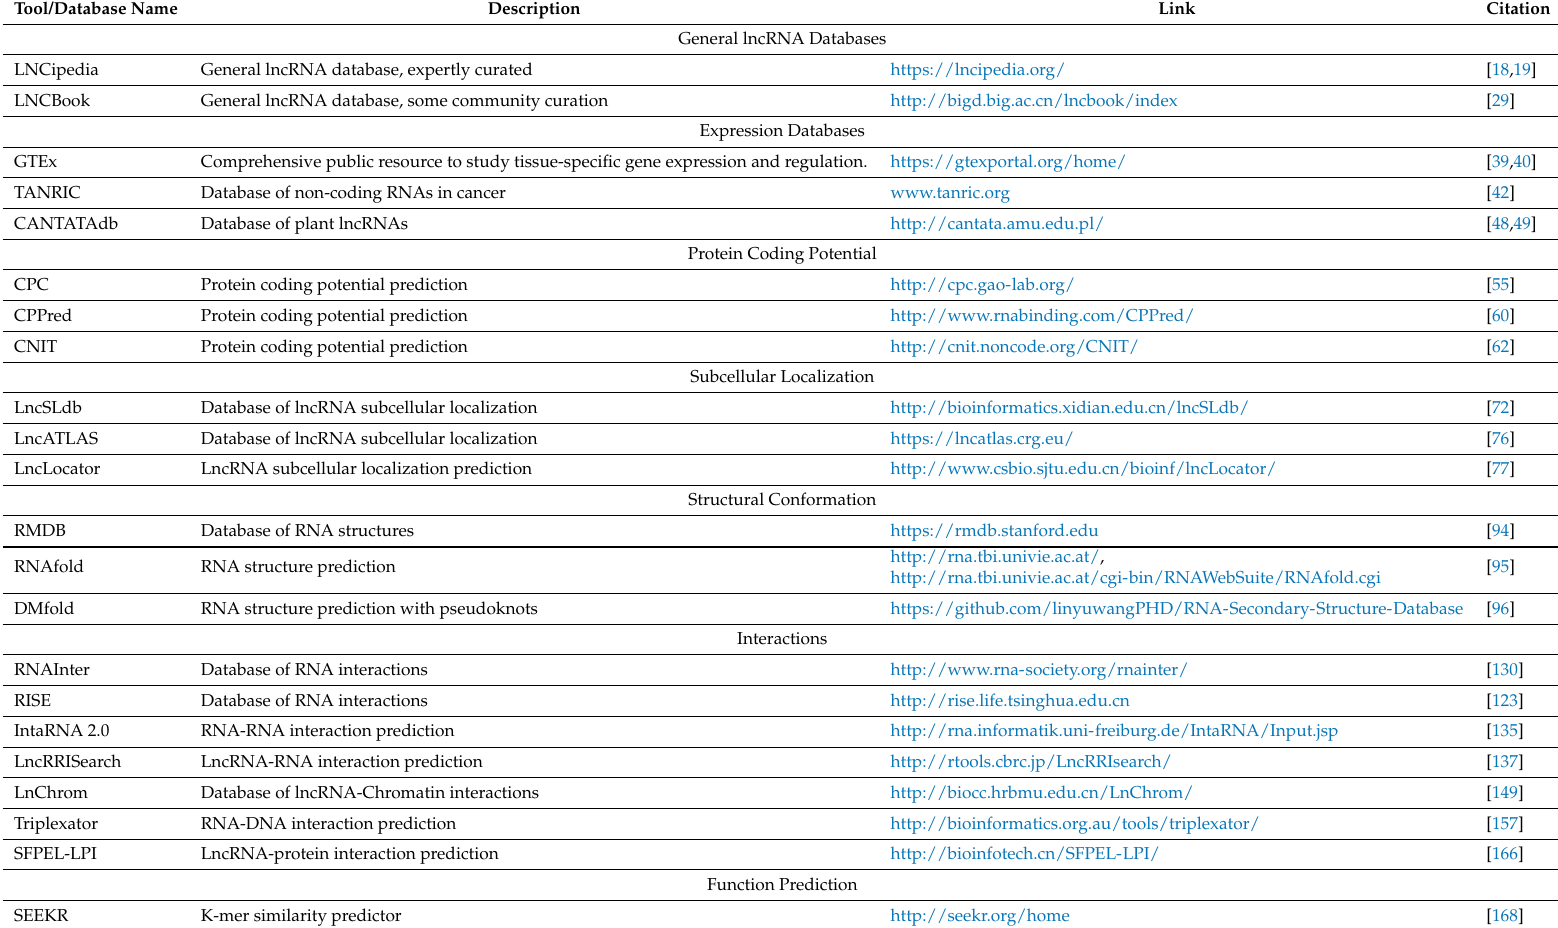
Table A1. List of tools and databases